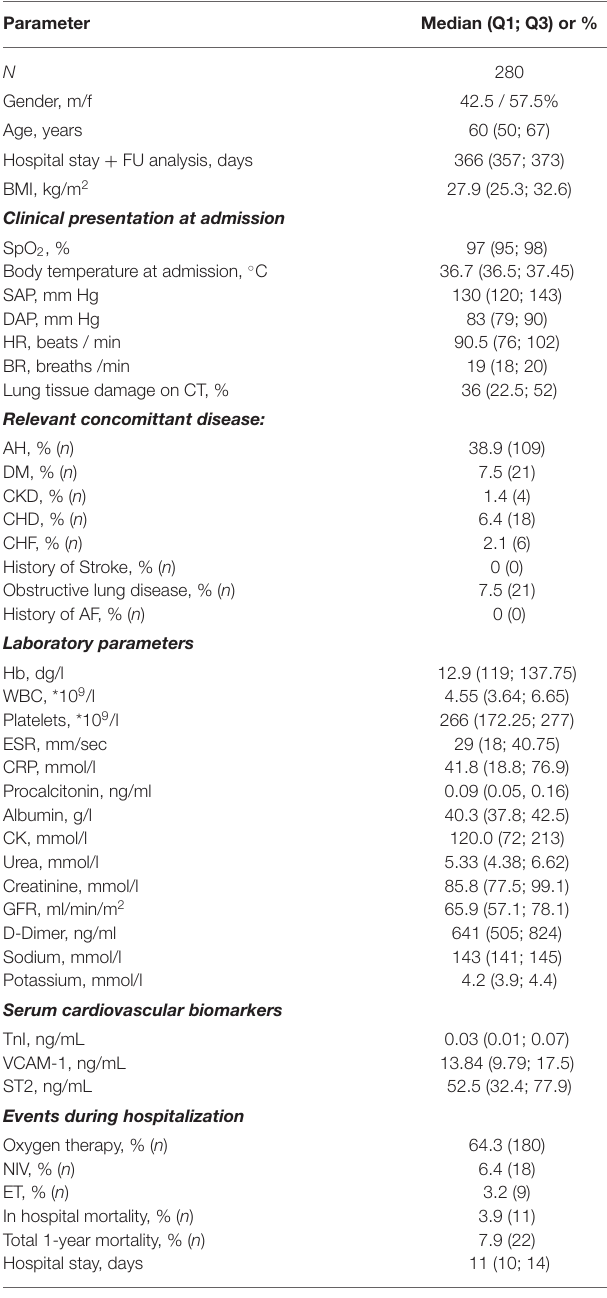
TABLE 1 | Characteristics of the study